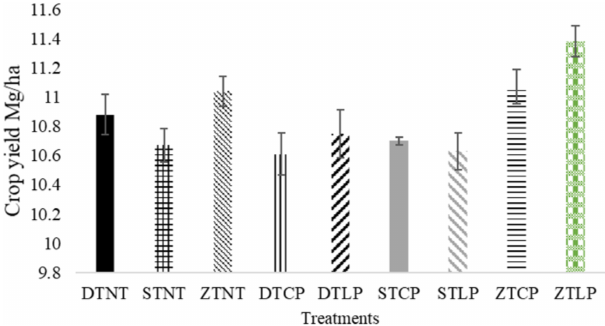
Figure 3. Crop yield in megagrams per hectare (Mgha − 1 ) for the traffic × tillage